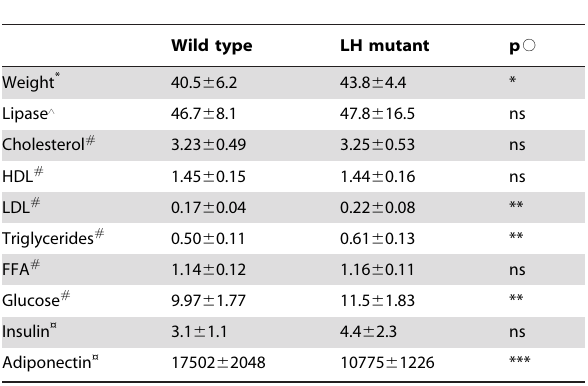
Table 2. Comparison of serum parameters of 8 months old female LH mutant and wild type mice after four months of high fat diet.